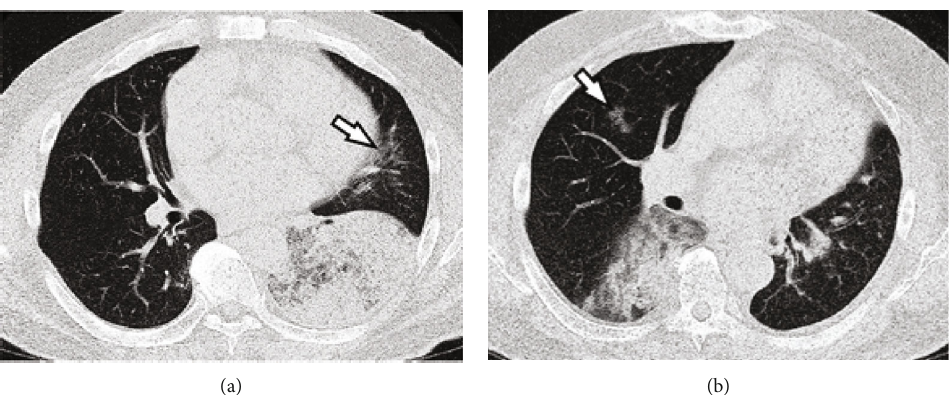
Figure 1: Axial CT images. (a) A chest CT image obtained 7 days after the initial visit shows a large in fi ltrative shadow, as well as a small in fi ltrative shadow that is suspected to be a skip lesion (arrow). (b) A chest CT image obtained 2 months after left lobectomy shows an in fi ltrative shadow with a skip lesion (arrow) in the right lung.